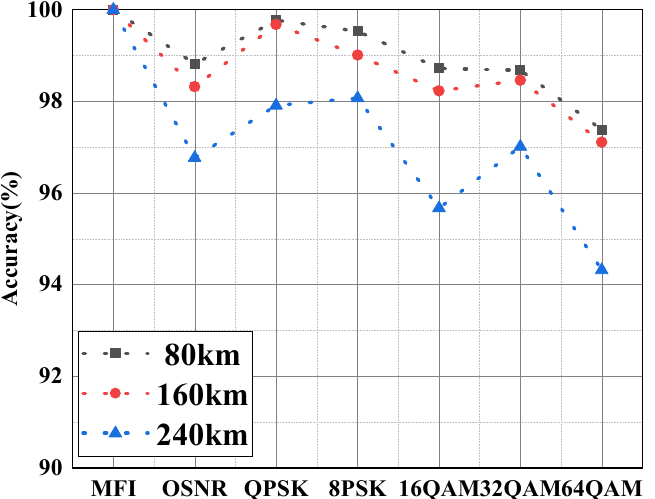
Figure 14. Accuracies for MFF-Net trained on data from 80 km, 160 km, and 240 km.